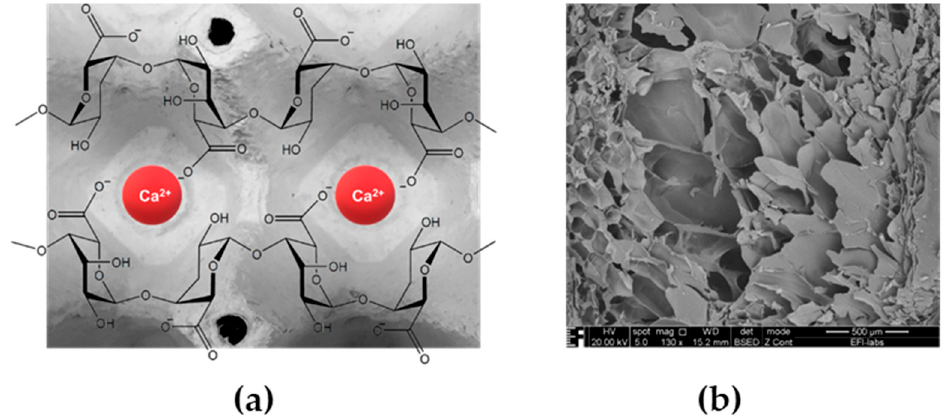
Figure 6. ( a ) Scheme for the interaction between calcium and alginate forming an eggbox-like structure. ( b ) Internal structure of the microsphere using scanning electron microscopy (SEM, magnification: 130×, scale bar indicates 500 µm).